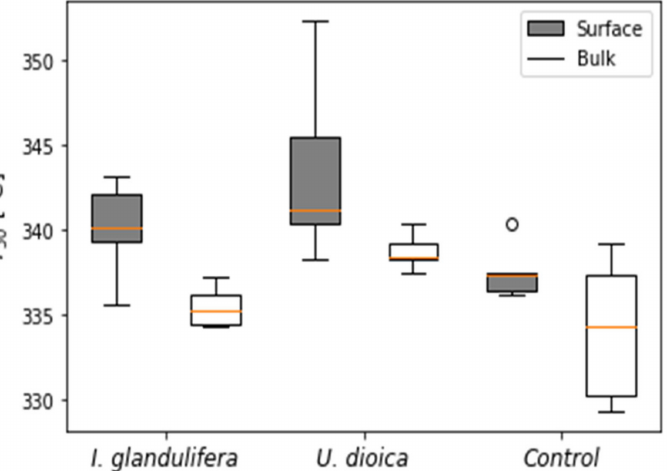
Figure 3. Thermal stability of SOM expressed as the temperature in ◦ C at which 50% of the SOM mass was burnt (T50) for surface (0–2 cm) and bulk layers (2–5 cm depth) of soil colonized by Impatiens glandulifera ( I. glandulifera ) and by Urtica dioica ( U. doica ) or of bare soil (Control) obtained fromthermogravimetric mass loss curves between 200 and 600 ◦ C. The boxes present the lower and upper 25th percentiles with whiskers showing the 1.5 fold interquartiles range (IQR) and all data points outside the 1.5 fold IQR depicted as empty